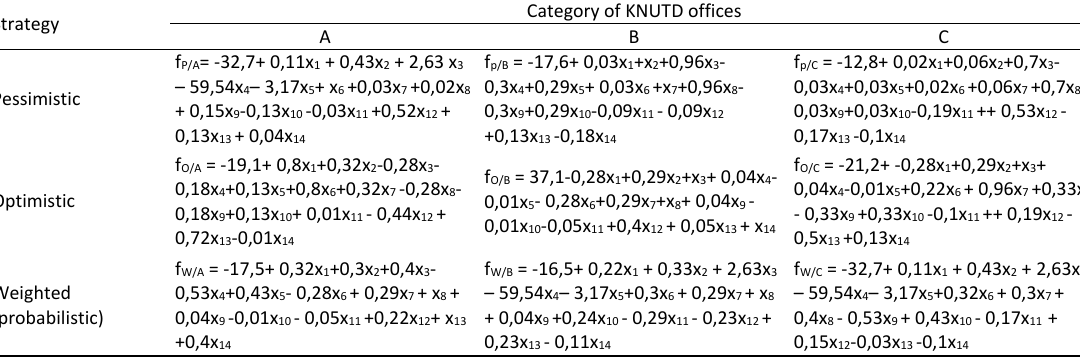
Table 8: A system for monitoring the level of energy efficiency achieved